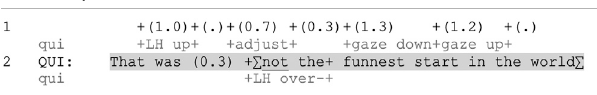
Extract 7 | 190729 KY Bruise